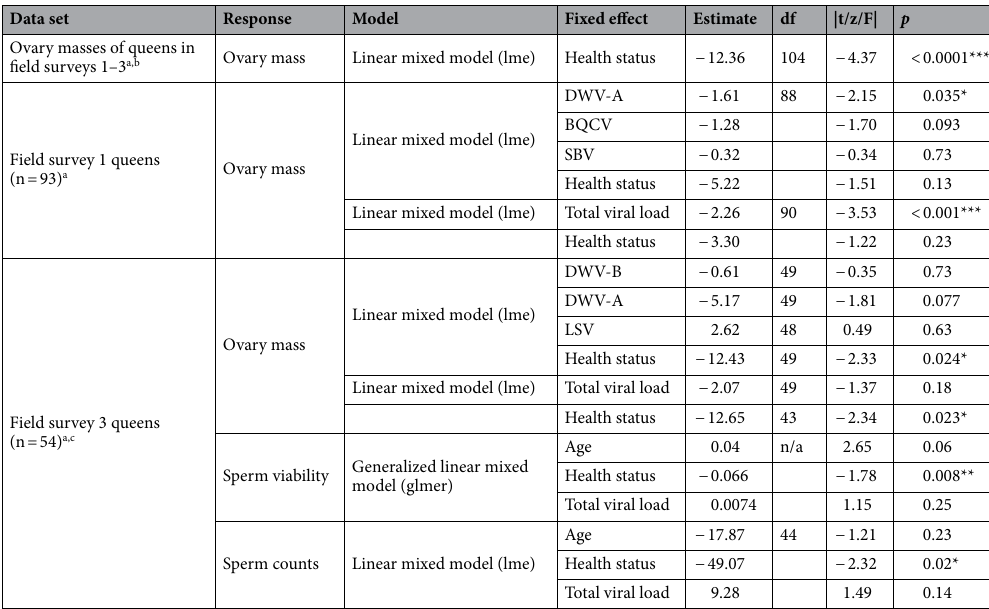
Table 2. Statistical parameters. a Models included queen source location as a random effect. b Survey 2 contributed only ovary mass data, and not sperm metrics. Survey 2 data were analyzed in conjunction with ovary mass data from surveys 1 and 3. c Generalized linear mixed models, used for the sperm viability model for survey 3, do not report degrees of freedom. For this model there were 54 observations and 7